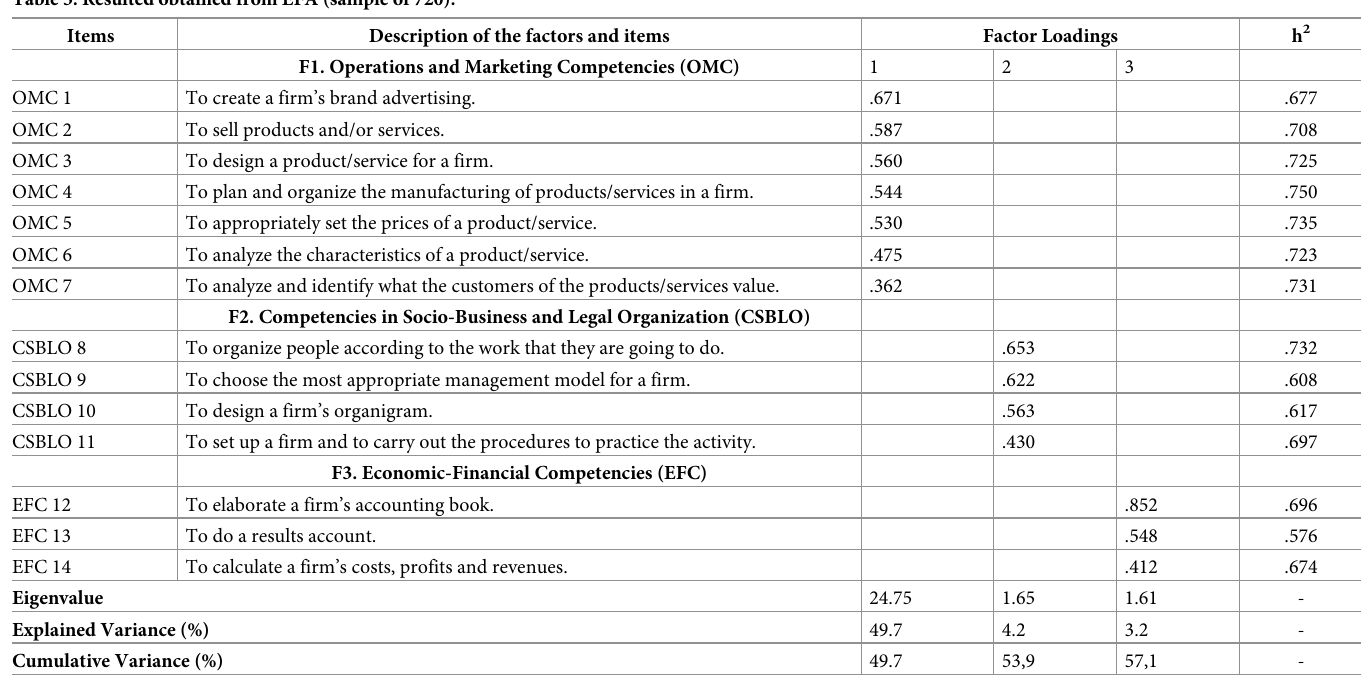
Table 5. Resulted obtained from EFA (sample of 720). Description of the factors and